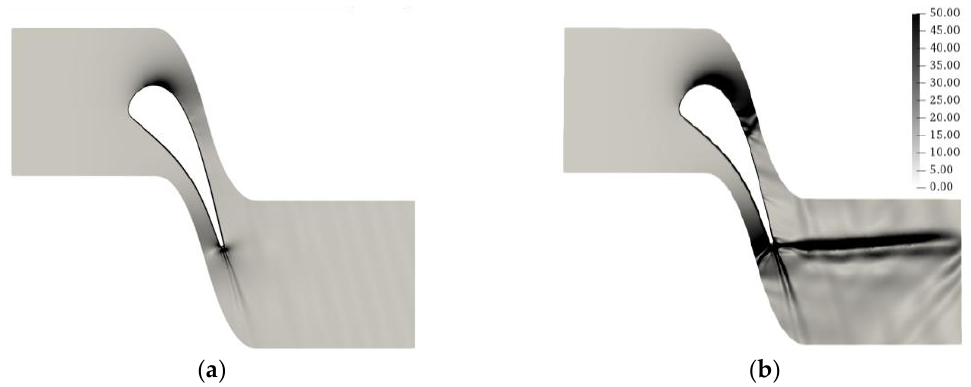
Figure 3. Contours of the normalized density gradient | ▽ ρ |/ ρ : ( a ) MUR129_ k-ω; ( b ) MUR241_ k-ω .